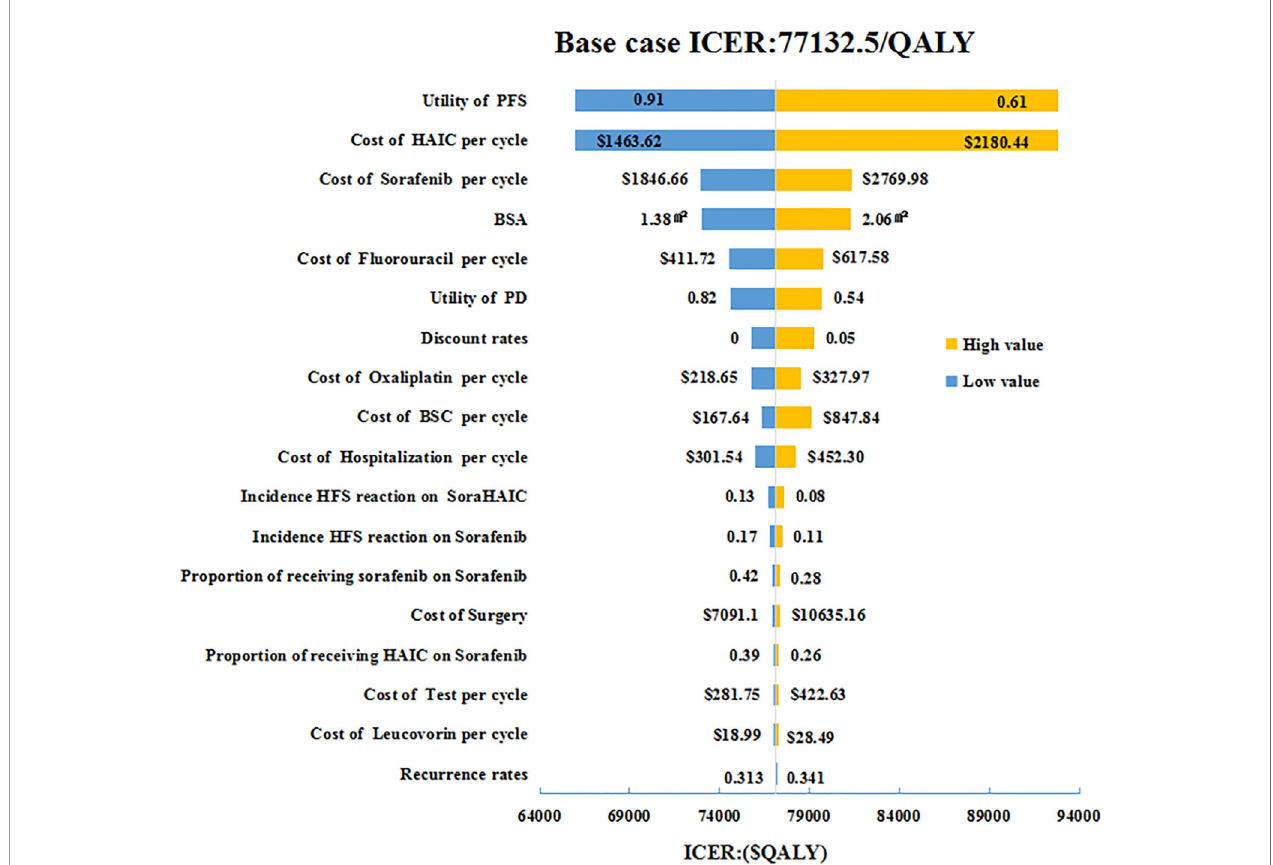
FIGURE 1 | One-way sensitivity analyses of HAIC plus sorafenib in comparison with sorafenib in China. HAIC, hepatic arterial infusion chemotherapy; BSA, body surface area; BSC, best supportive care; HFS, hand foot syndrome; PFS, progression-free survival; PD, progressive disease; ICER, incremental cost-effectiveness ratio.